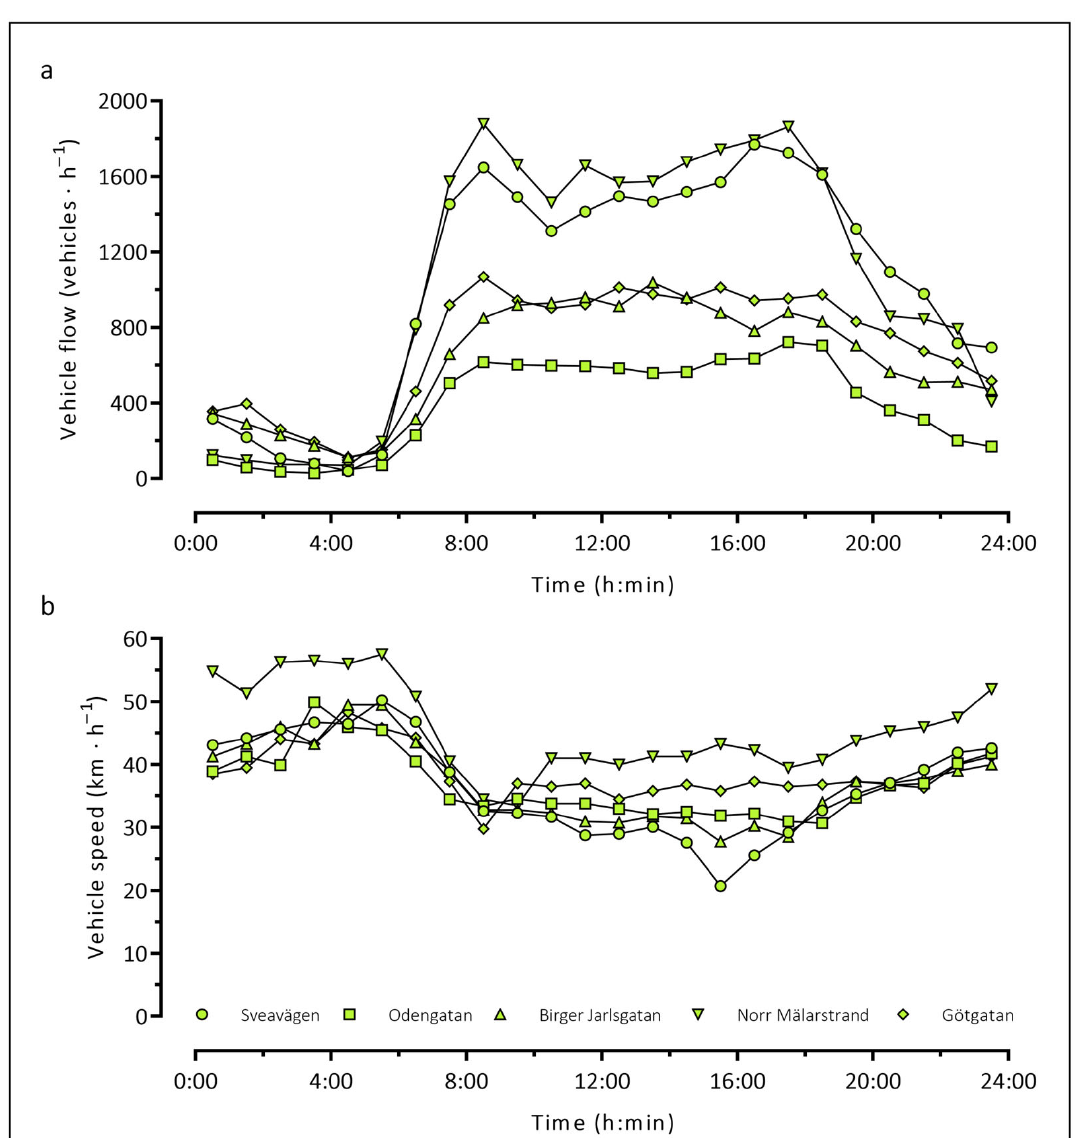
Figure A2. Vehicle flow ( a ) and average vehicle speed ( b ) per hour on minor arterials in inner urban areas of Stockholm. The measurement points show data for both driving directions during a typical weekday (Tuesday to Thursday) in April 2005. The ratio between light motor vehicles ( ≤ 3500 kg) and heavy (>3500 kg) was: 96.4%. Data has been collected by the City of Stockholm Transport De ‐ partment (in Swedish: Trafikkontoret, Stockholms stad). Further information about these traffic measurements can be found in the City of Stockholm report [46] .